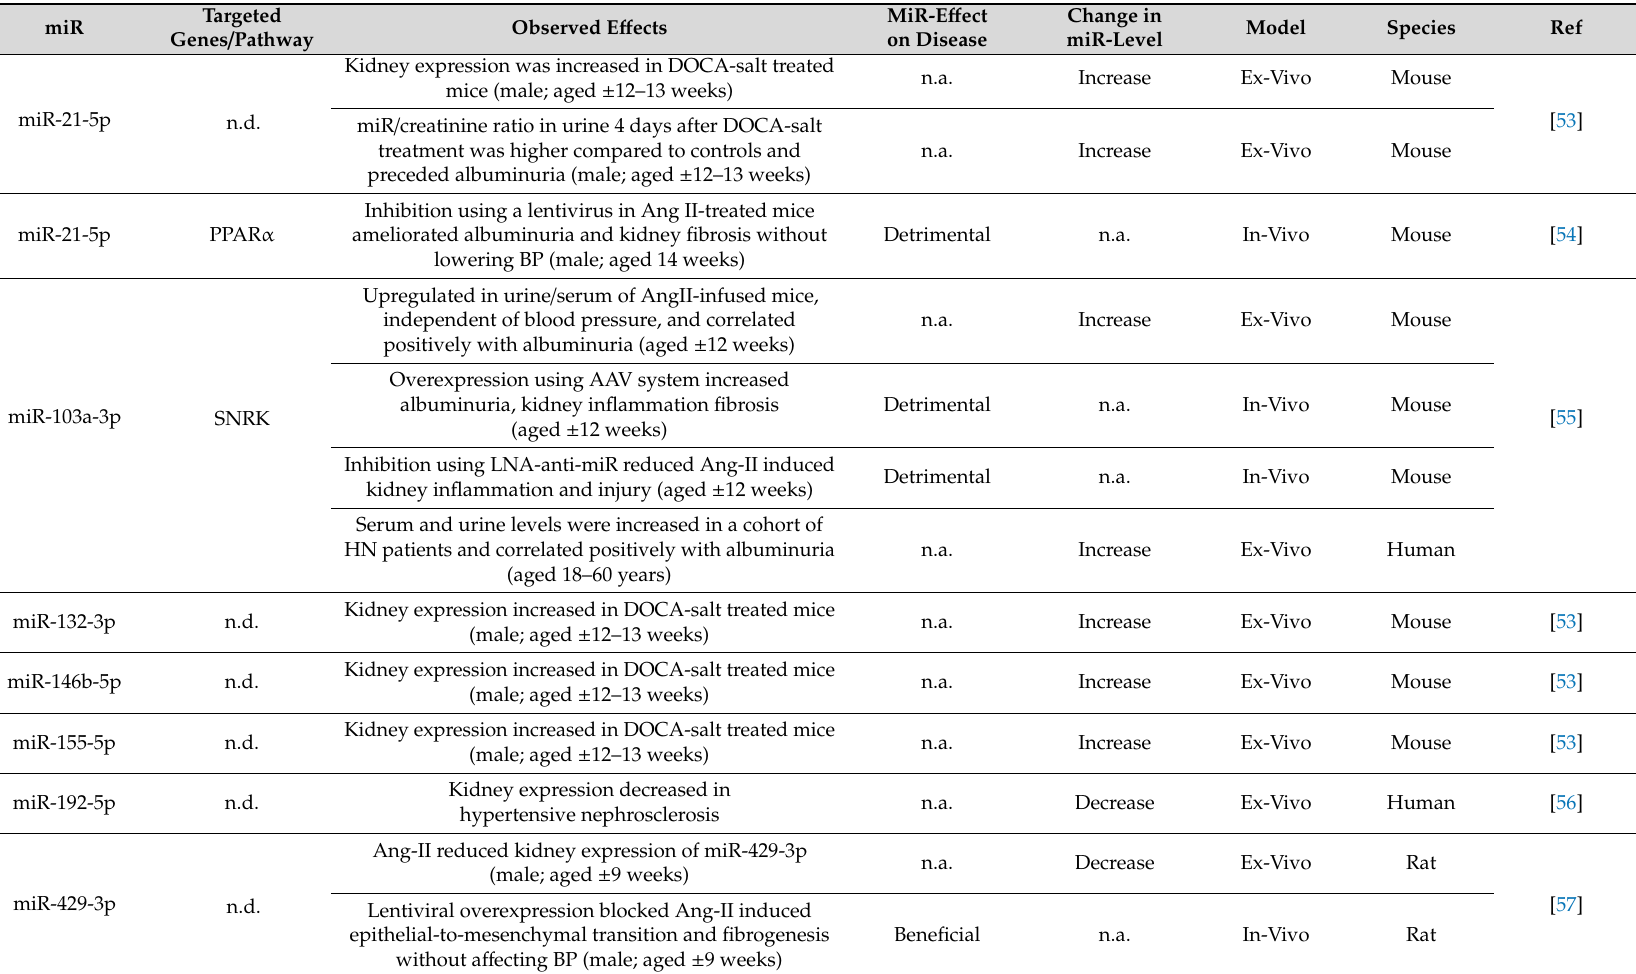
Table 3. Overview of miRs that are involved in hypertensive nephropathy (only ex-vivo / in-vivo evidence). Targeted miR Genes /